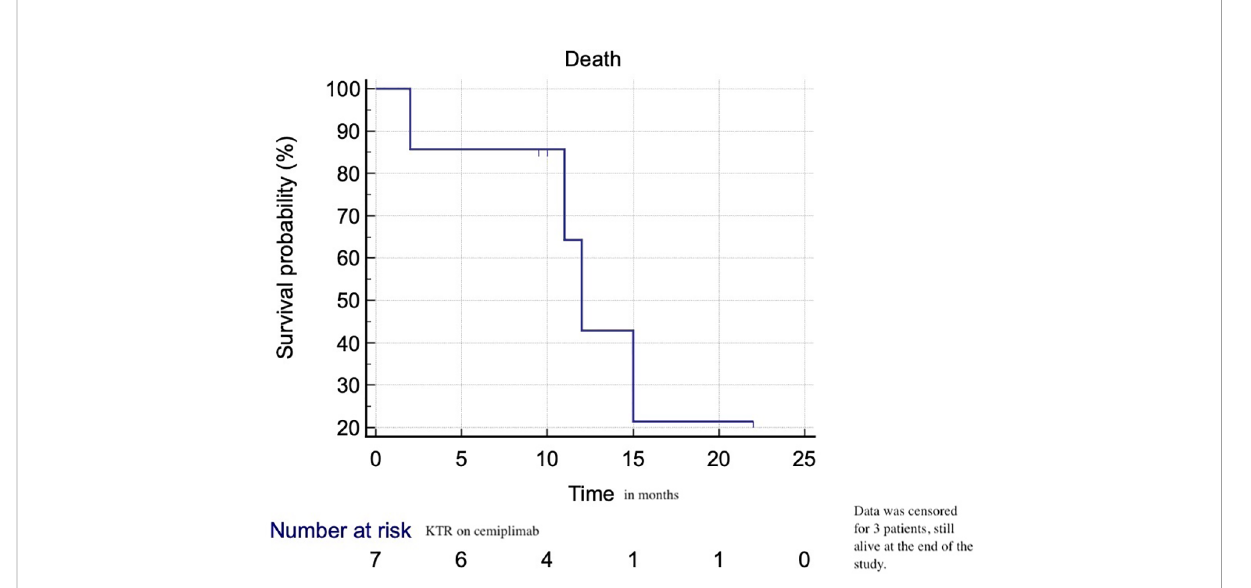
FIGURE 1 Overall survival of KTR on cemiplimab for advanced